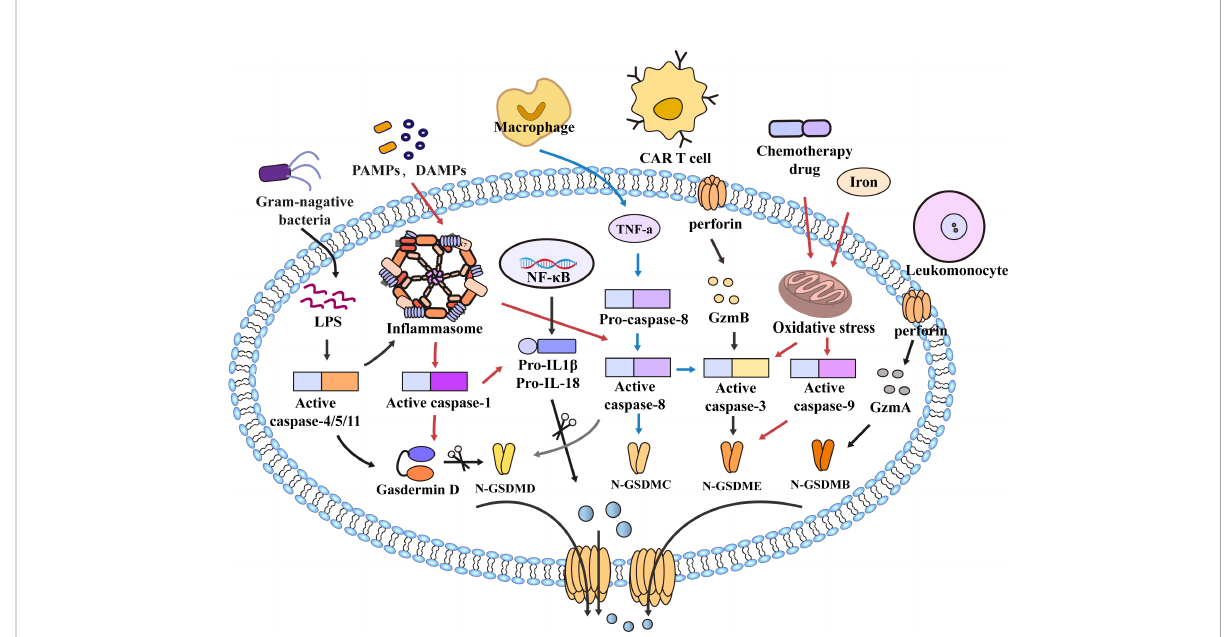
FIGURE 1 Molecular mechanism of pyroptosis. In the caspase-1-dependent pathway, PAMPs and DAMPs mediate in fl ammasome assembly and activate caspase-1, which cleaves GSDMD and pro-IL-1 b /18. N-GSDMD forms non-selective pores on the cell membrane surface, and IL-1 b and IL-18 are secreted out of the cell membrane through the pores formed by N-GSDMD, which further leads to cell lysis and death. In the caspase-1- independent pathway, LPS of bacteria activates caspase-4/5/11 and cleaves GSDMD to trigger pyroptosis. However, caspase-4/5/11 can also activate in fl ammasome assembly and caspase-1 to induce pyroptosis. In addition, in the caspase-8-mediated pathway, TNF- a induces the activation of caspase-8, cleavage of GSDMD leads to pyroptosis, and caspase-8 can also cleave GSDMC and GSDME, Furthermore, the NLRP3 in fl ammasome also activate Caspase-8. Granzyme also mediates pyroptosis, such as GzmB released from CAR T cells induces pyroptosis by activating caspase-3 and cleaving GSDME. In the caspase-9-mediated pathway, chemotherapy drugs and iron cause mitochondrial stress, activate caspase-3/9, and cleave GSDMB/E to mediate pyroptosis. Furthermore, GzmA in cytotoxic leukomonocyte enters target cells via perforin and cleaves GSDMB resulting in cell pyroptotic death. Similarly, GSDMB/C/E also forms pores to mediate the secretion of in fl ammatory mediators out of the membrane, amplify the in fl ammatory response, and promote cell